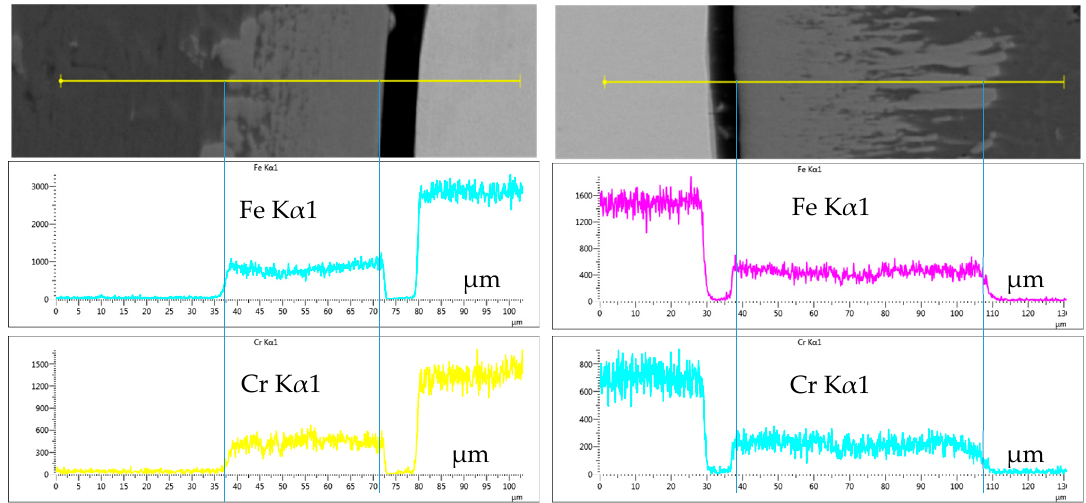
Figure 25. EDX line microanalysis.